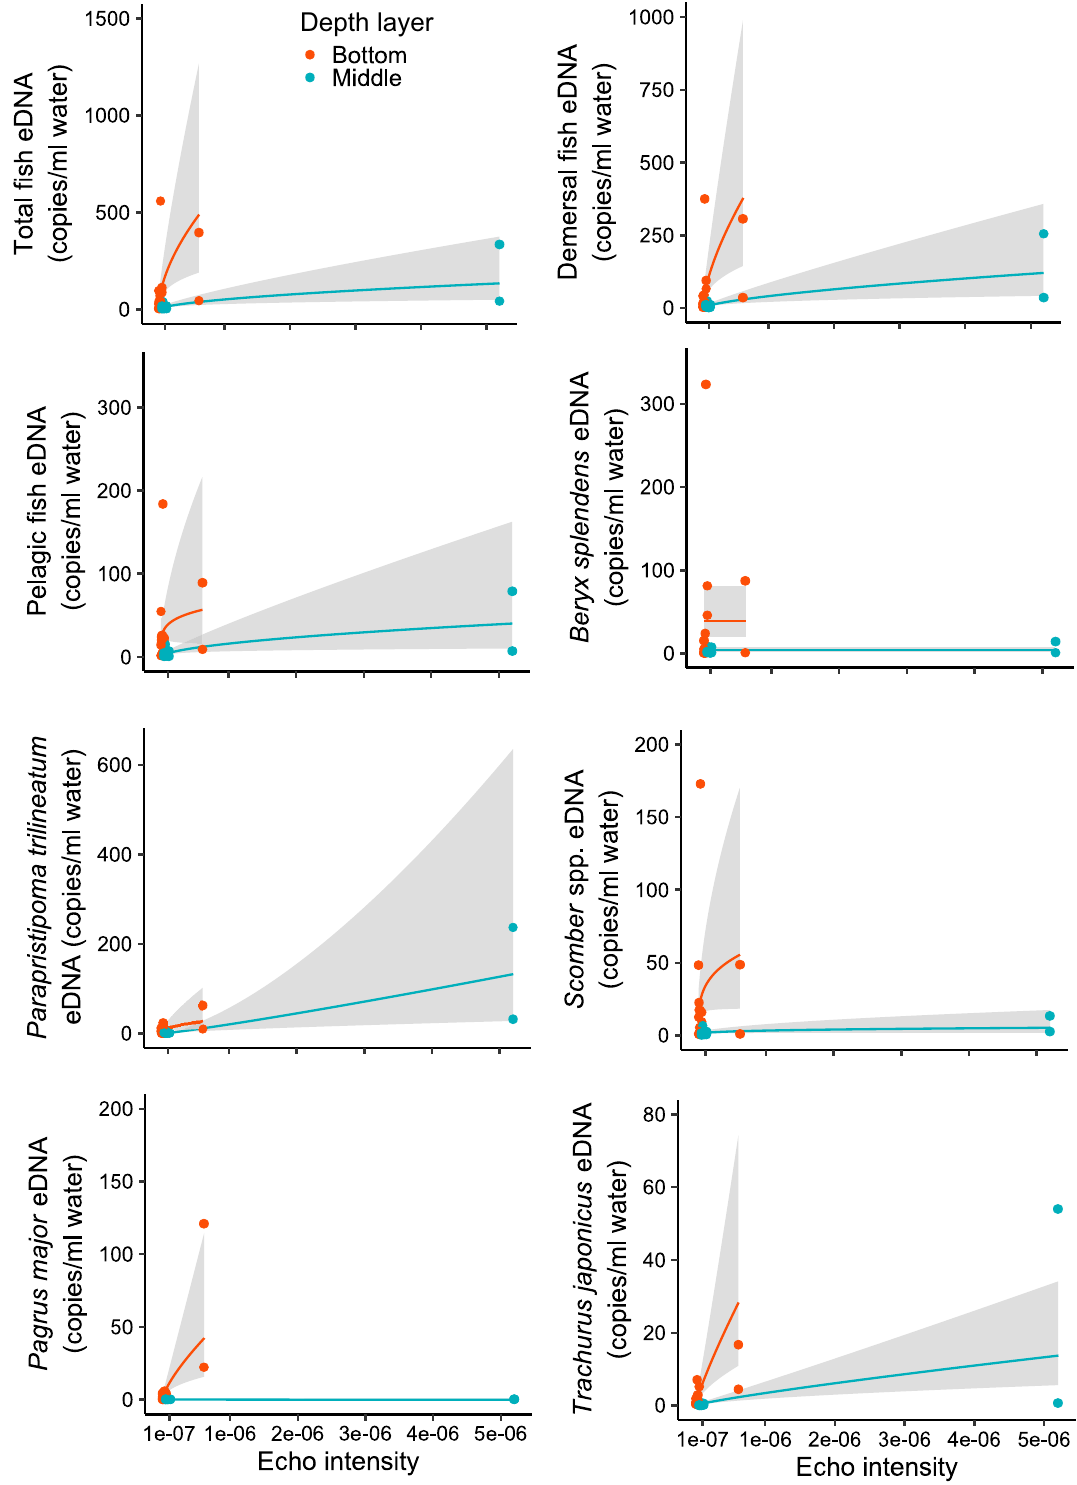
Figure 4. The relationships between echo intensity and eDNA copies of total fish, demersal fish, pelagic fish, Beryx splendens , Parapristipoma trilineatum , Scomber spp., Pagrus major , and Trachurus japonicus . The red and turquoise blue lines indicate median values in the bottom and middle layers respectively, while each color circle indicates raw values in the respective layers. The gray shaded area represents a 95% confidence interval, as determined from the generalized linear